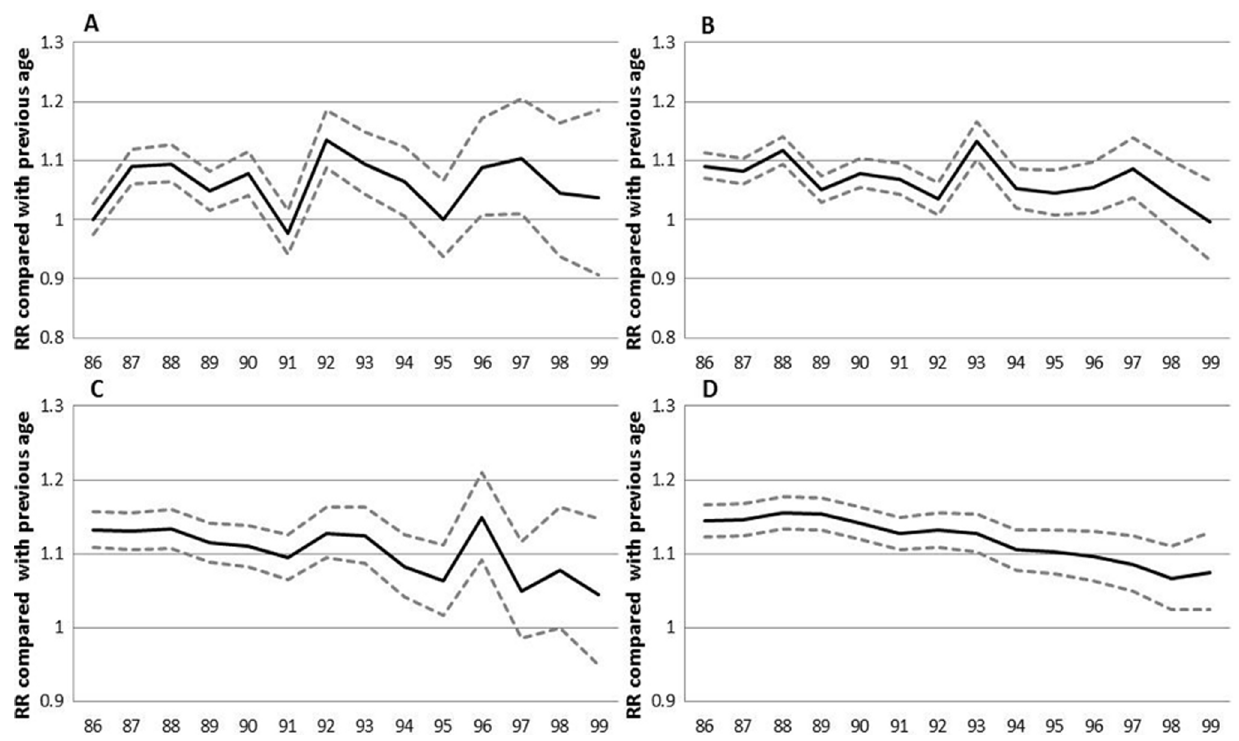
Figure 7. Relative risk of age on risk of CVD, men and women. Relative risk increase of age on risk of cardiovascular disease (men A, women B) and mortality from cardiovascular diseases (men C, women D). Solid line is relative risk, RR, and dashed lines upper and lower 95% confidence intervals. RR=1 indicates no increased risk.